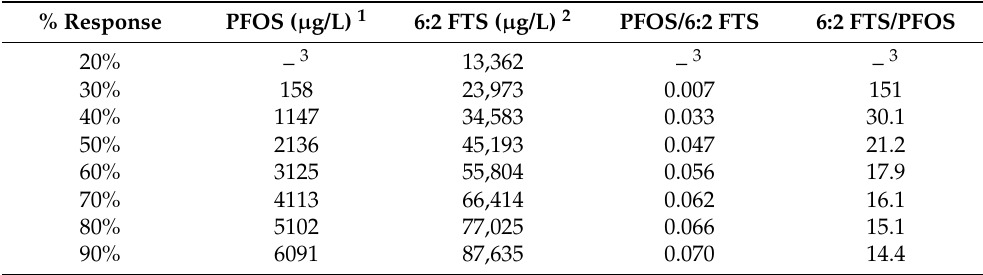
Table 5. Predicted doses of PFOS and 6:2 FTS (applied individually, rather than as a mixture) that yield the same response (reduction in mean